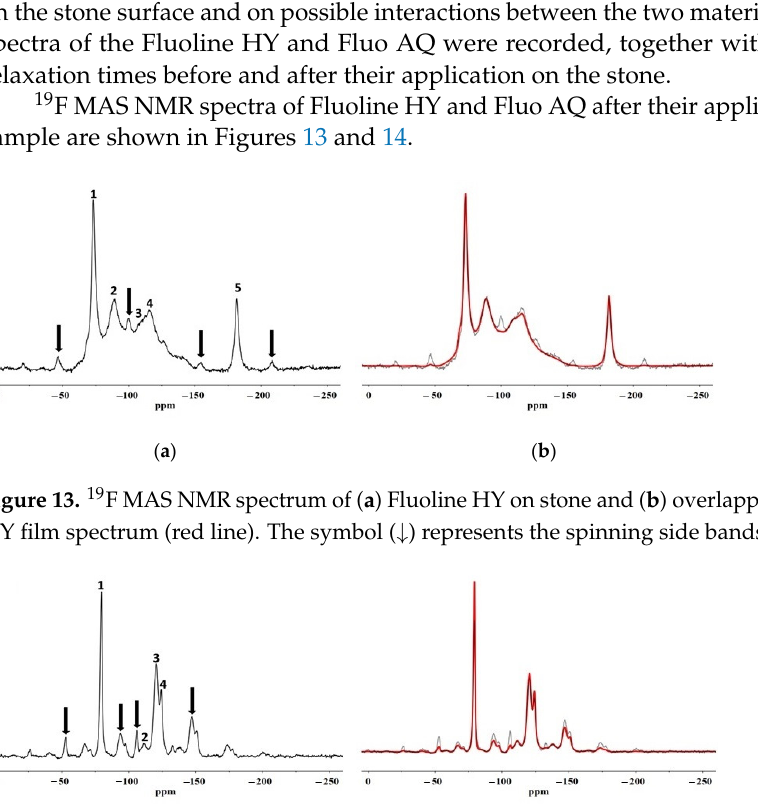
Figure 12. Sequence of repetitive units in Fluo AQ.